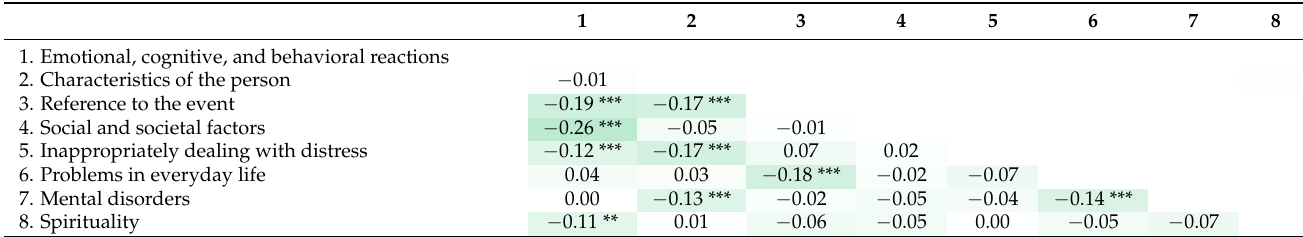
Table A2. Correlations between second-order